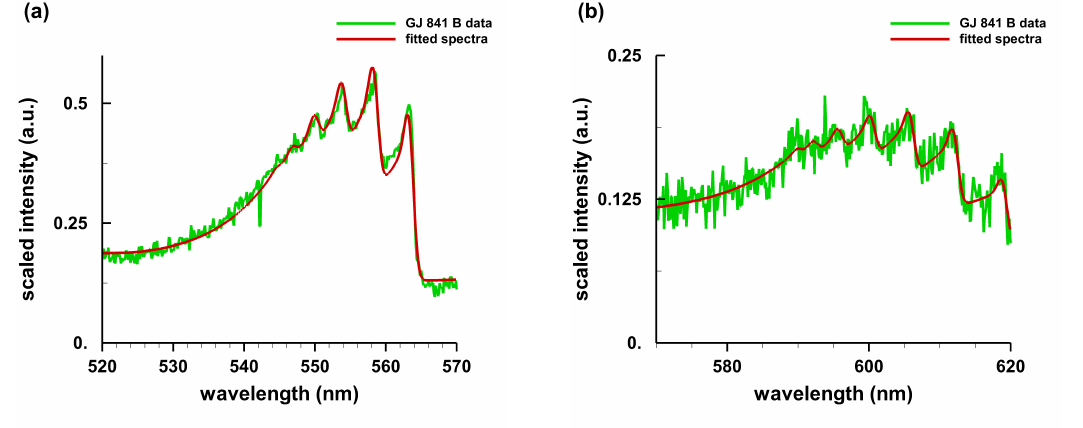
Figure 17. Inverted and fitted spectra for: ( a ) ∆ v = − 1 bands yielding T = 4.5kK; and ( b ) ∆ v = − 2 bands indicating T = 4.2kK. The fitted spectral resolution equals δλ = 1.5 nm for the spectra in ( a , b